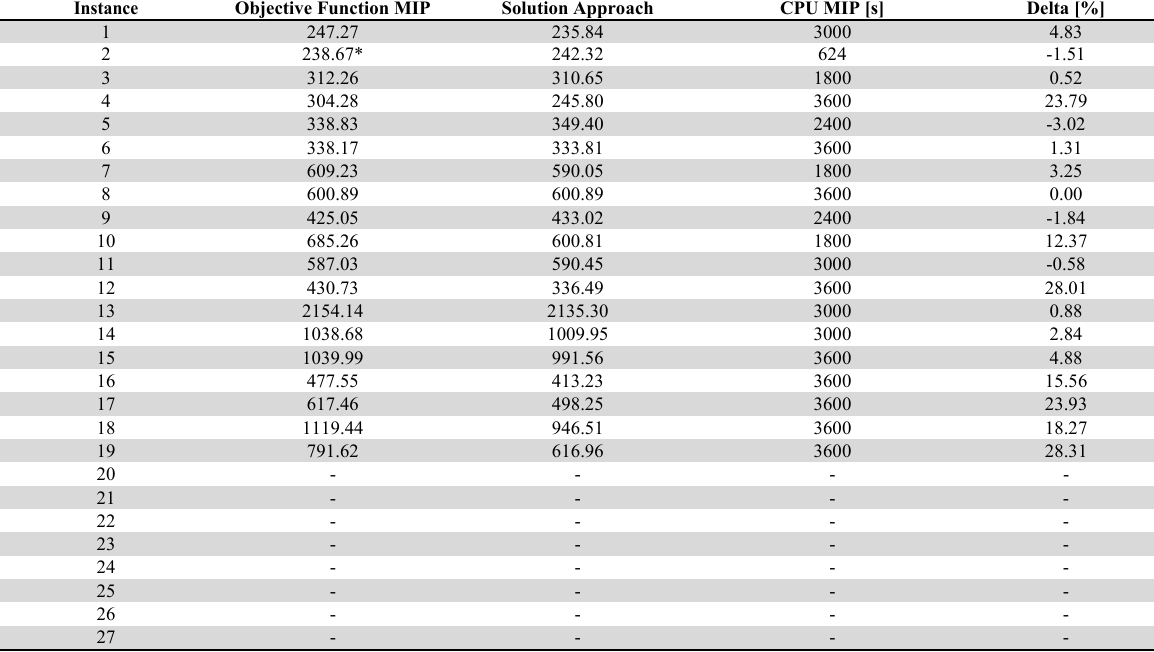
Performance of MIP and the gap respect to the proposed approach without packing